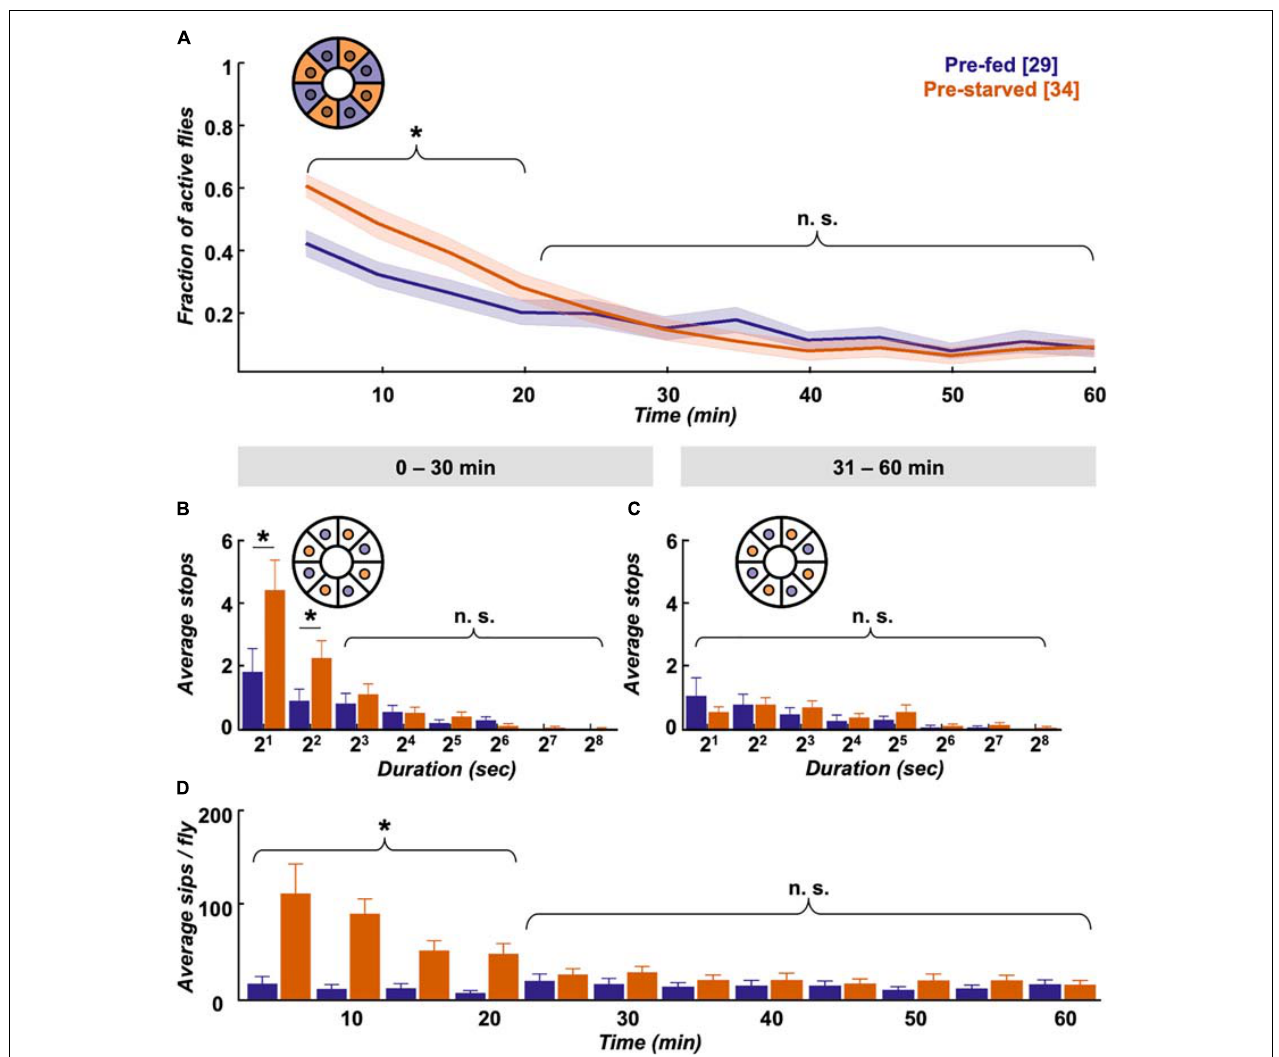
FIGURE 3 | Pre-starved flies show higher activity and food intake within first 30 min. (A) Both pre-fed (deep purple) and pre-starved (orange) flies exhibit raised activity on the food patch assay (inset schematic) during the first 20 min, with pre-starved flies showing significantly higher activity than pre-fed flies. Both groups reach baseline levels subsequently. Data is presented as means ± SEM in 5 min bins. N values are given in brackets. (B) Initially starved flies make significantly more stops of 2–7 s duration than pre-fed flies in the first 30 min, (C) but not in the next 30 min on the food patch (inset schematic). (D) Feeding rate, as measured on the flyPAD, indicates that initially starved flies show higher initial sip rate than the pre-fed flies, which quickly decreases to a comparable sip rate. *Indicate significance levels following Mann–Whitney U-tests (alpha = 0.05), n.s. = not significant. Horizontal lines represent comparison between pre-fed and pre-starved flies from a single group. Curly braces represent identical significance levels across multiple groups. N values are given in